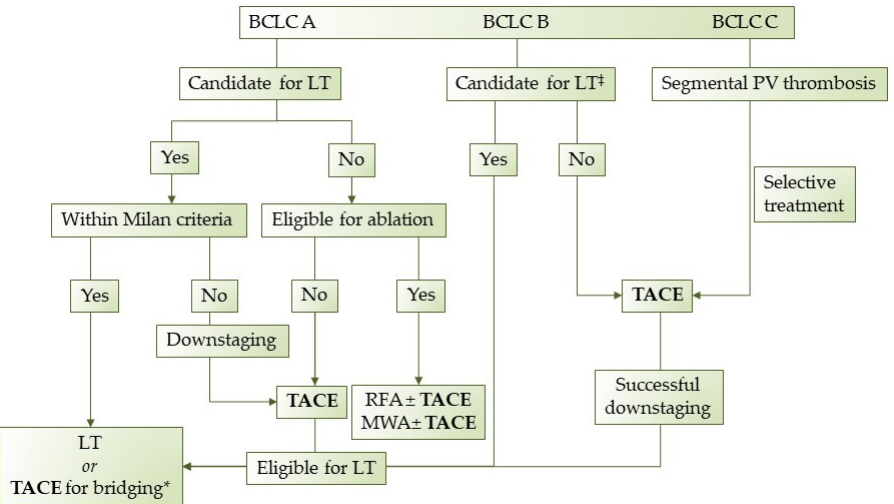
Figure 2. Proposed treatment algorithm regarding TACE in HCC patients. LT: Liver transplantation, TACE: transarterial chemoembolization, RFA: radiofrequency ablation, MWA: microwave ablation, * when in waiting list > 6 months, ‡ extended liver transplant criteria (size,